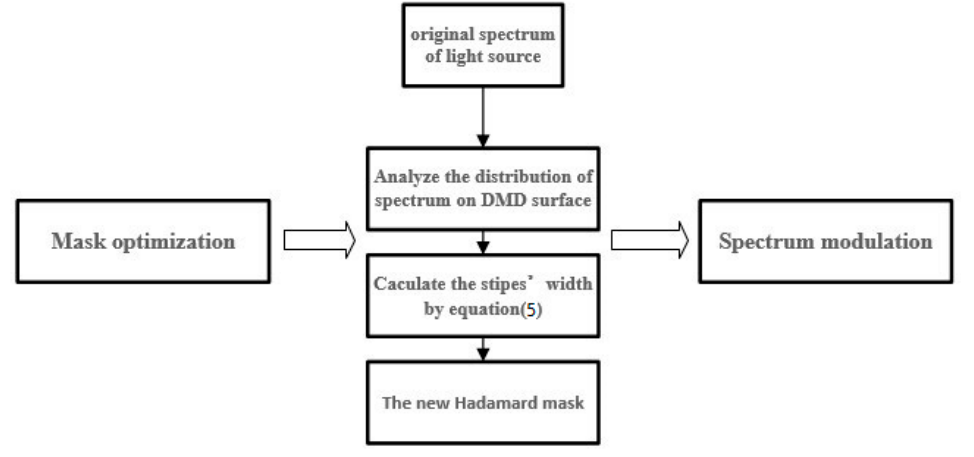
Figure 10. Flowchart of mask optimization.